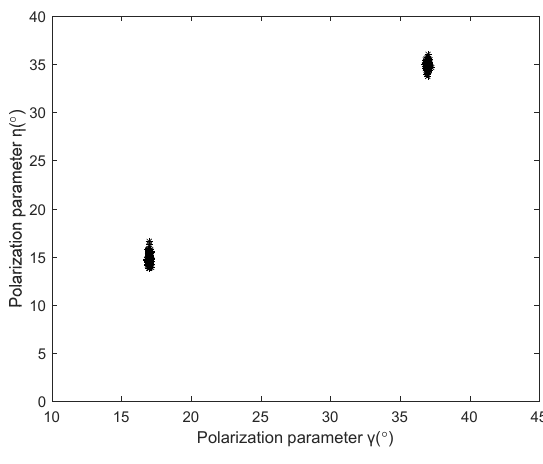
Figure 7. Scatter plot of θ and γ .